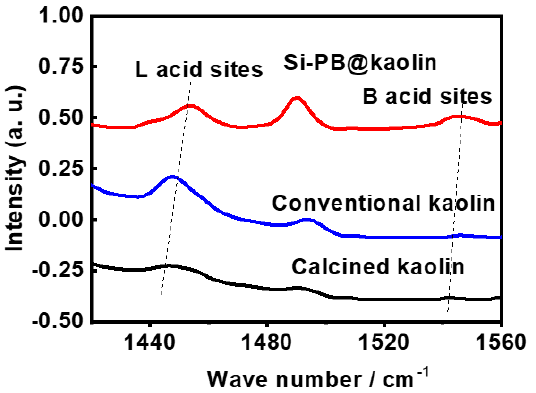
Figure 4. Py-FTIR spectra for conventional kaolin, calcined kaolin and Si-PB@kaolin.